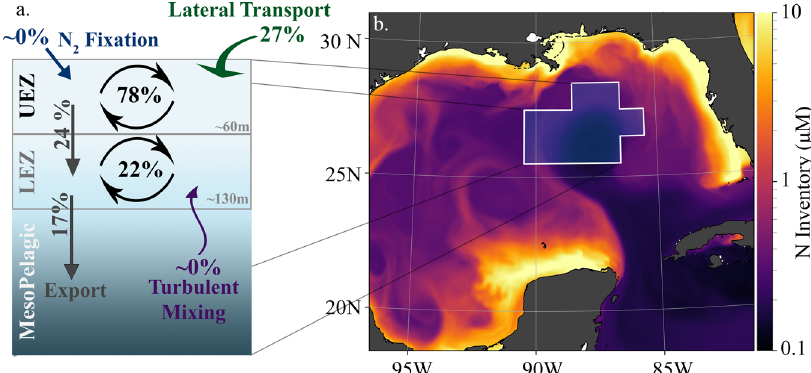
Fig. 4 Schematic of transport mechanisms and fl uxes of the northeast Gulf of Mexico. a Arrows and values and fl uxes observed or estimated from model relative to euphotic zone net primary productivity including turbulent mixing (purple), N 2 - fi xation (blue), lateral transport (green), gravitational sinking (gray) and primary production (black). Upper and lower euphotic zones are indicated. b Monthly surface snapshot of nitrogen inventories for May 1993 in limits of data extending 1.5x the interquartile range of the data.